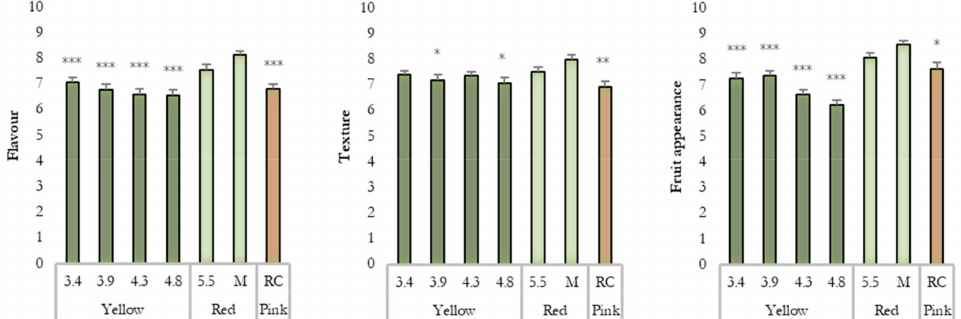
Figure 6. Consumer’s ( n = 59) scores for flavor, texture, and fruit appearance for the breeding lines, the original Mando landrace (M), and the commercial variety Rosa Candido (RC). Bar errors represent the standard error of the mean. Scores significantly di ff erent from the original landrace (Mando, M) are marked with asterisks (* p < 0.05, ** p < 0.01, *** p < 0.001, according to the Student-Newman-Keuls